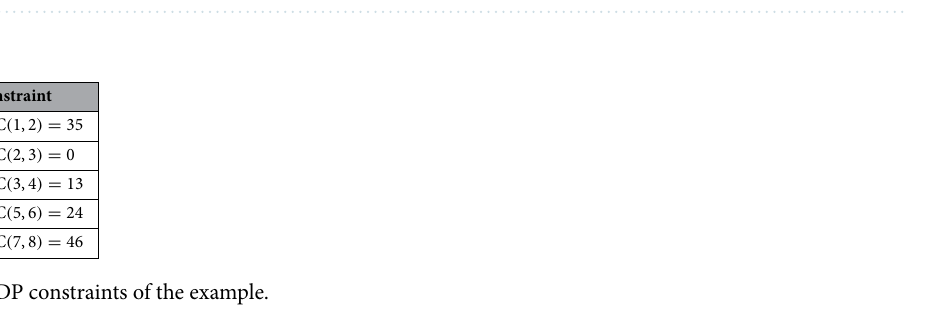
Table 1. Initial values fill in the DP constraints table.